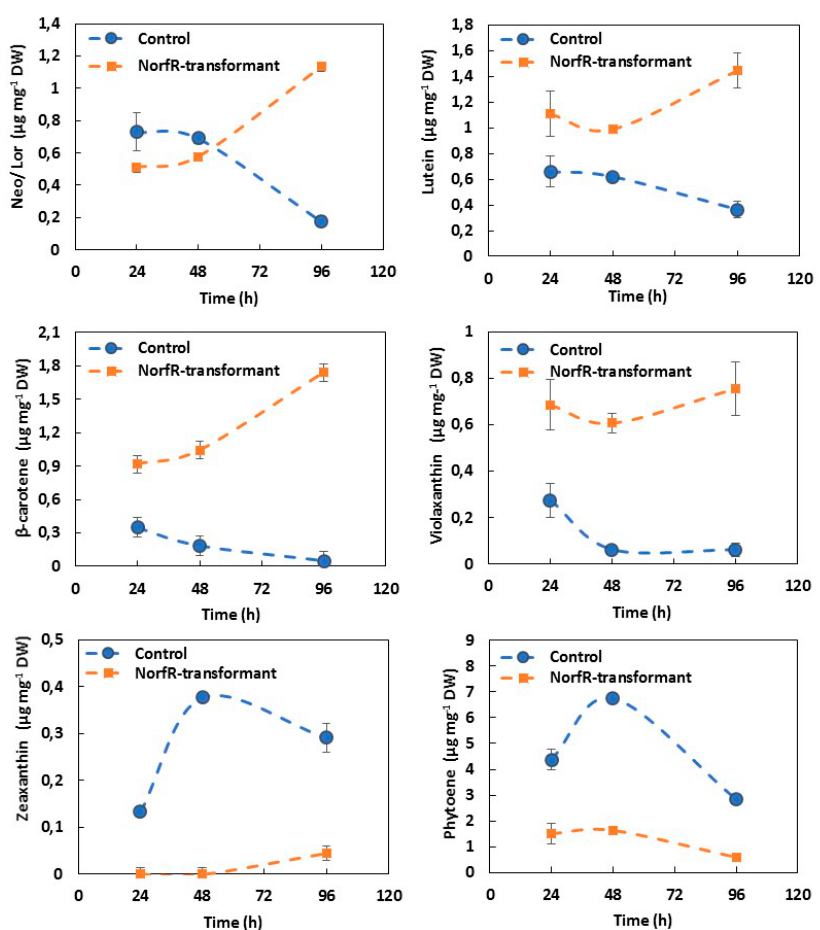
Figure 4. Time-course evolution of the main carotenoid pigments in C. reinhardtii control ( ) and Norf R -transformant ( (cid:4) ) cells incubated with norflurazon (1.5 µ g mL − 1 ). Values are the average of three biological replicates and bars indicate standard deviation. Neoxanthin and Loroxanthin (Neo/Lor) are expressed as unique values since they are not resolved in the analytical conditions used.